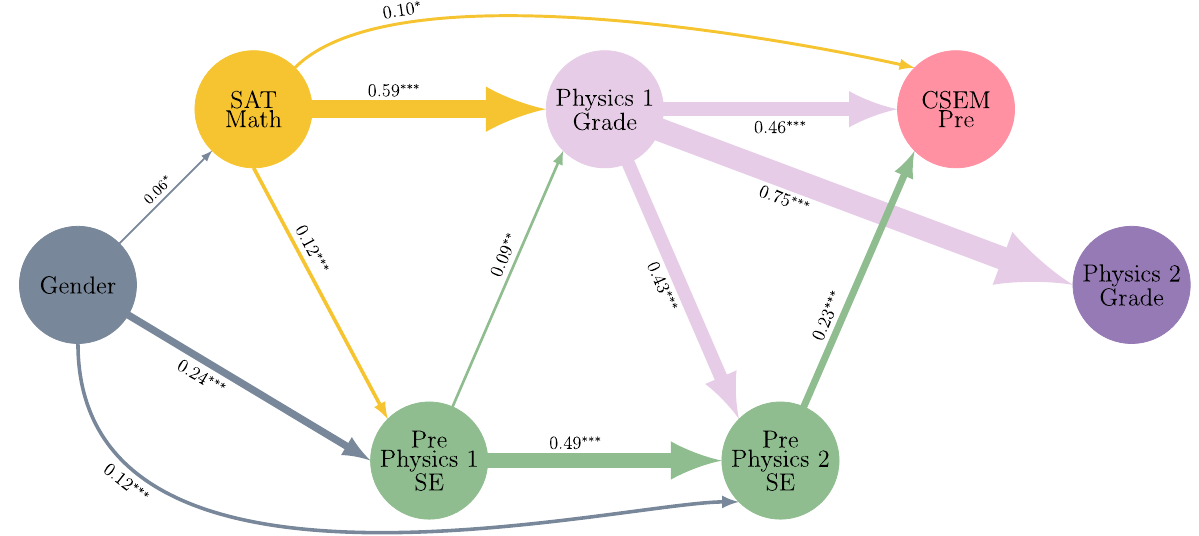
3. Results of the structural equation modeling between gender and course grade through pre self-efficacy in Physics 1 and Physics 2, SAT math, Physics 1 grade, and the CSEM pre. The line thicknesses correspond to the magnitude of β values. All p values are indicated by *** for p < 0 . 001 and ** for p < 0 . 01 . Each arrow with the line connecting two variables in the diagram indicates the direction of